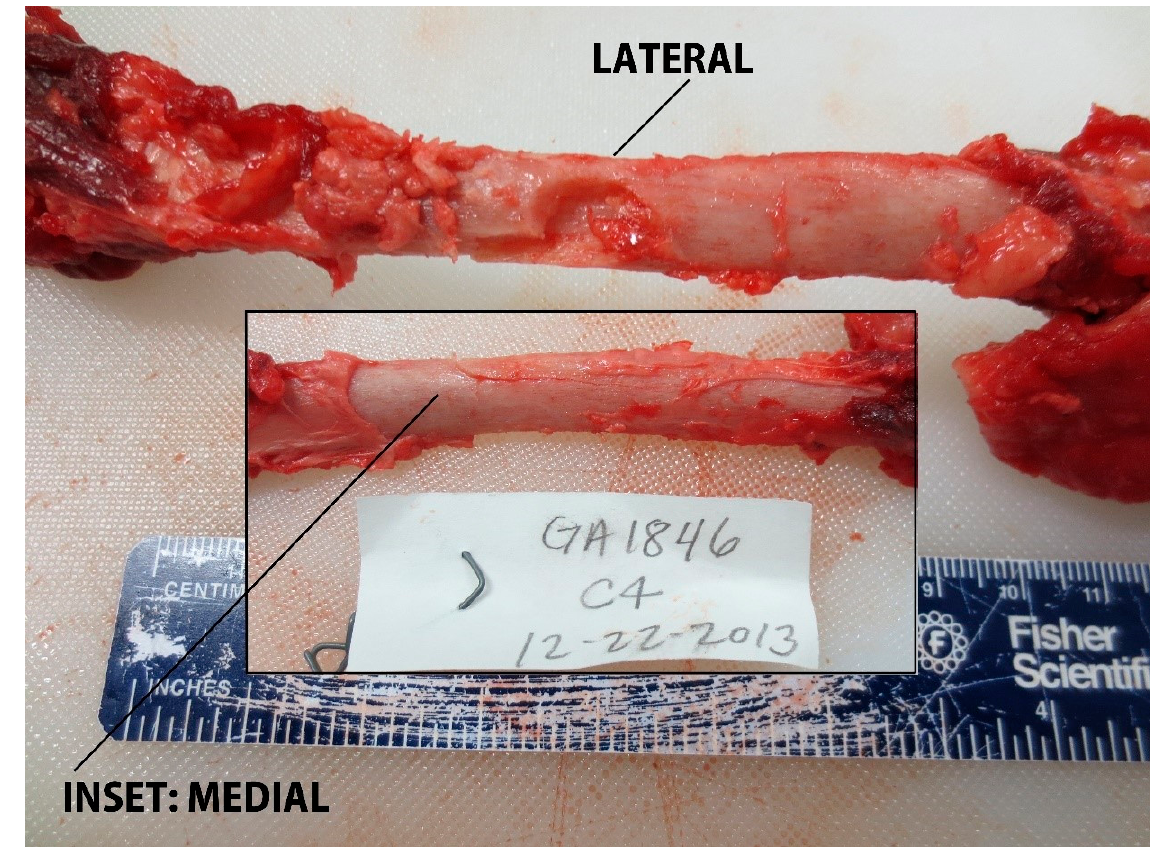
Figure 6. Rib impact in grid partition C on GA1846 (adult) with fragmentation and linear scoring of cortex on the lateral side of the rib, and a fracture apparent on the medial side of the rib. Table 2. Impact label, wound classification (NSE = no visible subdermal effect, OP = over-penetration), sample blubber thickness, and gross description of wound sites. Unless otherwise stated, the biopsy impact created a well circumscribed full-thickness biopsy of the skin and blubber layer. Penetration depths mentioned in the gross description were measured from the dissection plane (inner surface of blubbler layer), not from the external surface of the wound, and do not include measurements of the full thickness penetration of the skin/blubber. Measurements are approximate due to the irregular tearing of soft